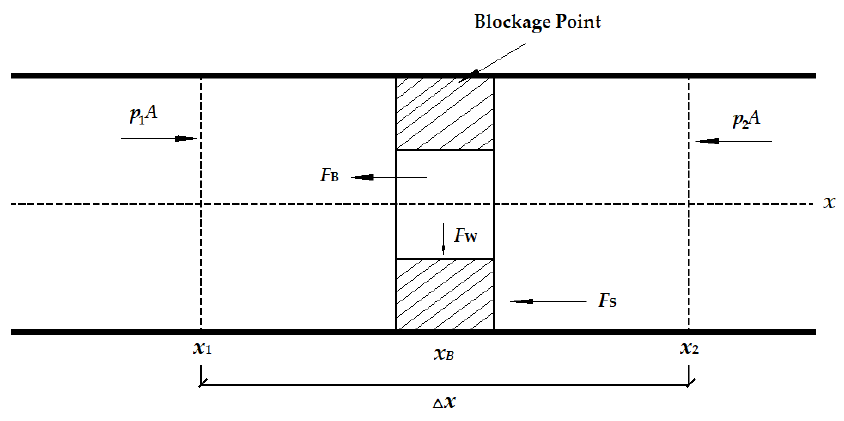
Figure 1. Physical model of blockage segment.